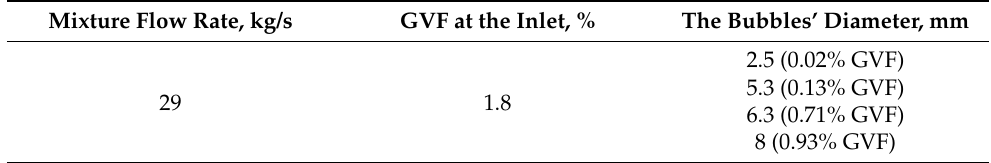
Table 3. The investigated flow conditions for the validation of bubbly flow regime [47].